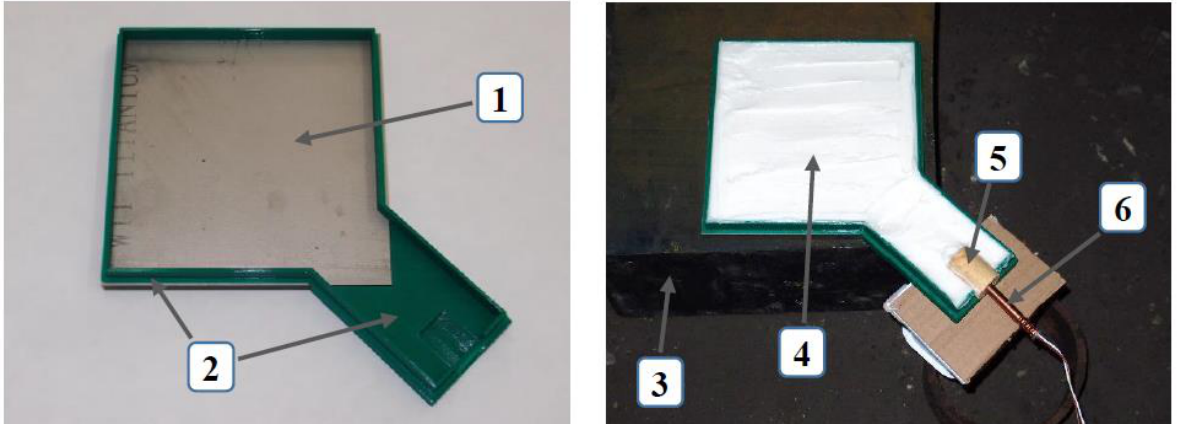
Figure 1. Technological system for strengthening titanium using the explosive method. 1 — titanium plate, 2 — elements obtained by additive techniques from PLA, 3 — steel base, 4 — explosive, 5 — TNT detonator, and 6 — blasting cap.